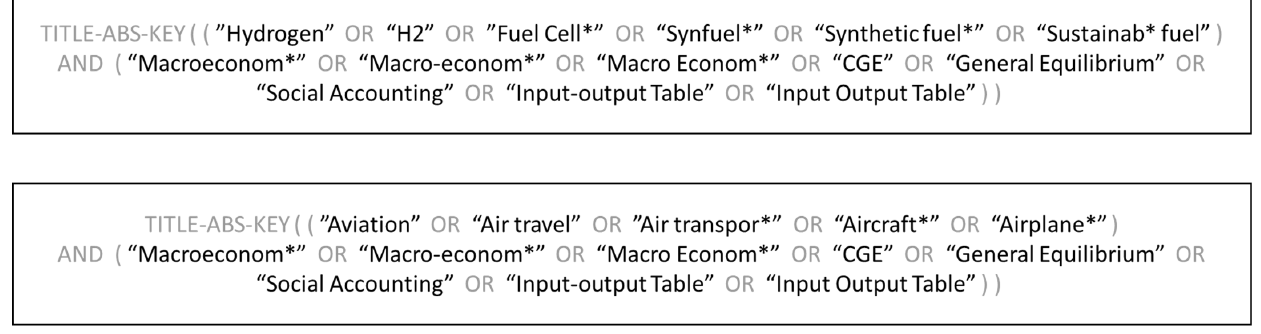
Figure 2. Search strings applied to the literature databases. The first string represents the search for computable general equilibrium models in the hydrogen context and the second one covers the search for computable general equilibrium studies related to aviation.